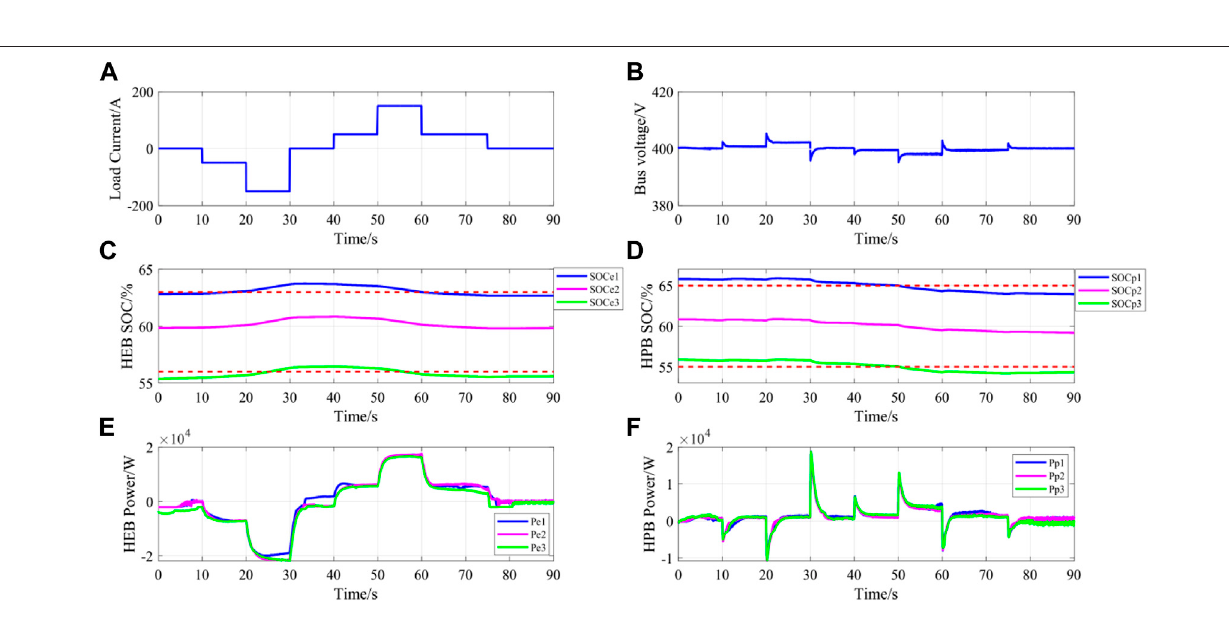
FIGURE 15 | Experimental results of DC microgrid in step load change: (A) Load current; (B) Bus voltage; (C) High-Energy Battery SOC; (D) High-Power Battery SOC; (E) Output power of High-Energy Battery; (F) Output power of High-Power Battery).